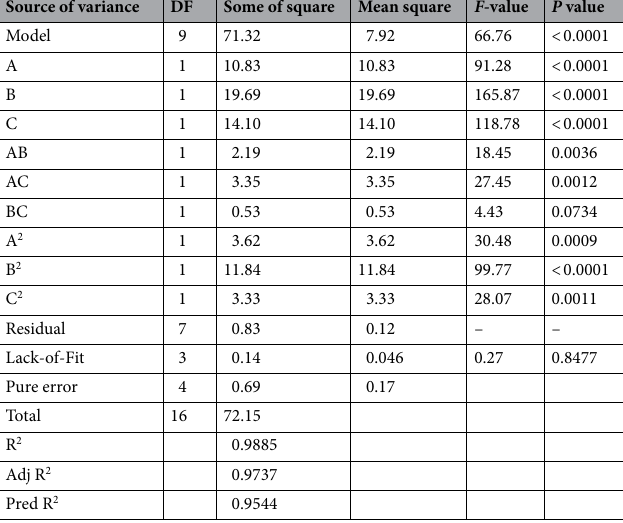
Table 1. ANOVA for the proposed model of SFHP extraction